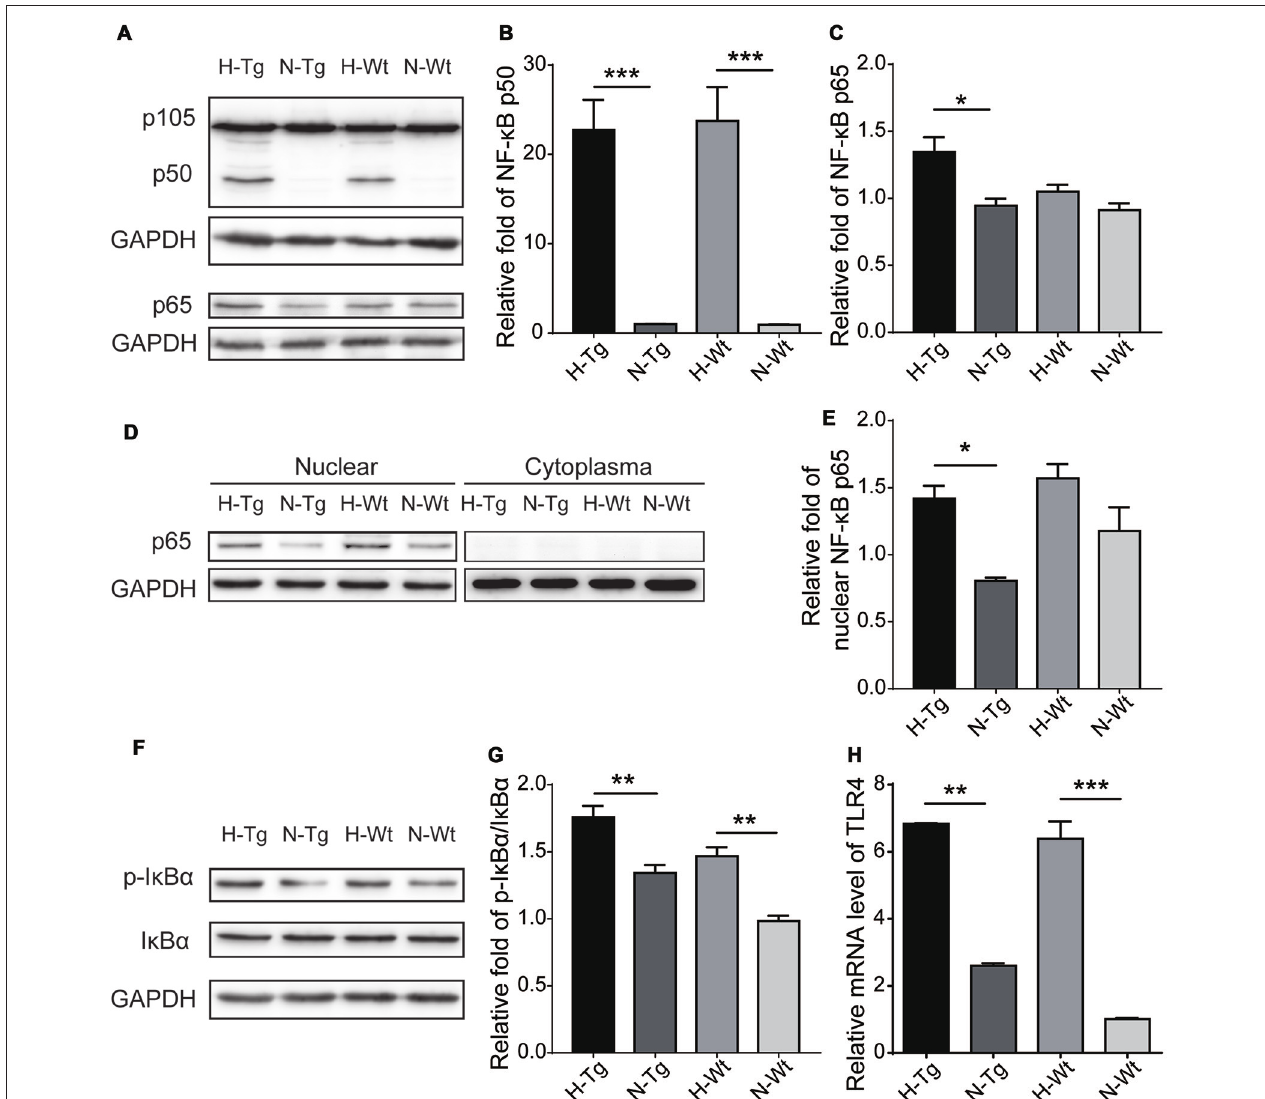
FIGURE 7 | Acute hypoxic treatment activated Nuclear factor- κ B (NF- κ B) pathway. Protein levels of key players in NF- κ B pathway were tested with western blotting. Protein levels of NF- κ B p65, p50 and p-I κ B α /I κ B α increased significantly in hypoxia group indicating activation of NF- κ B pathway (A,B,C,F,G) . Nucleoprotein level